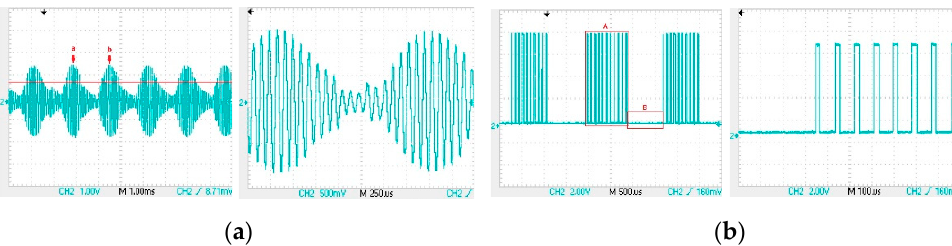
Figure 13. Waveform diagram of OUT3 signal and OUT4 signal: ( a ) filter output OUT3; ( b ) output OUT4 of the second